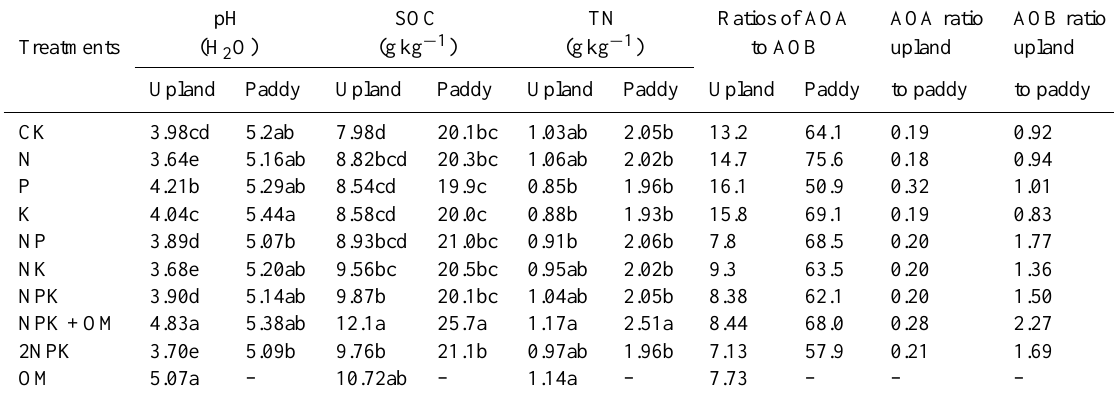
Table 1. Soil properties and ratios of AOA and AOB under different long-term field fertilization treatments.